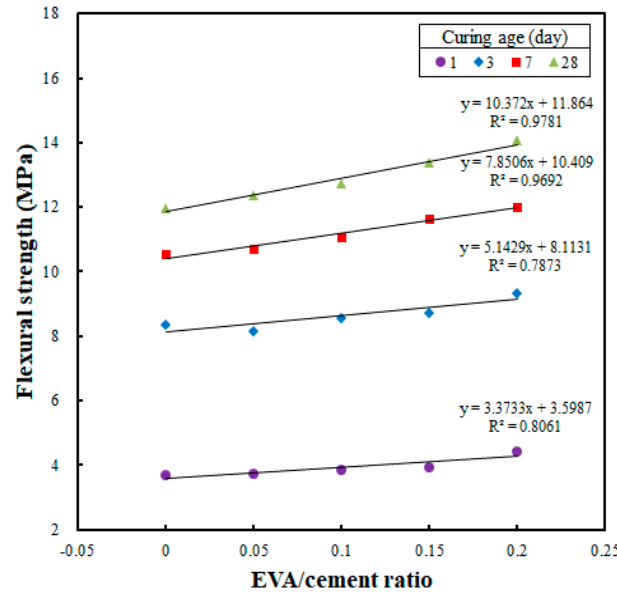
Figure 10. Relationship between EVA / cement ratio and flexural strength in printed specimens at different curing ages.